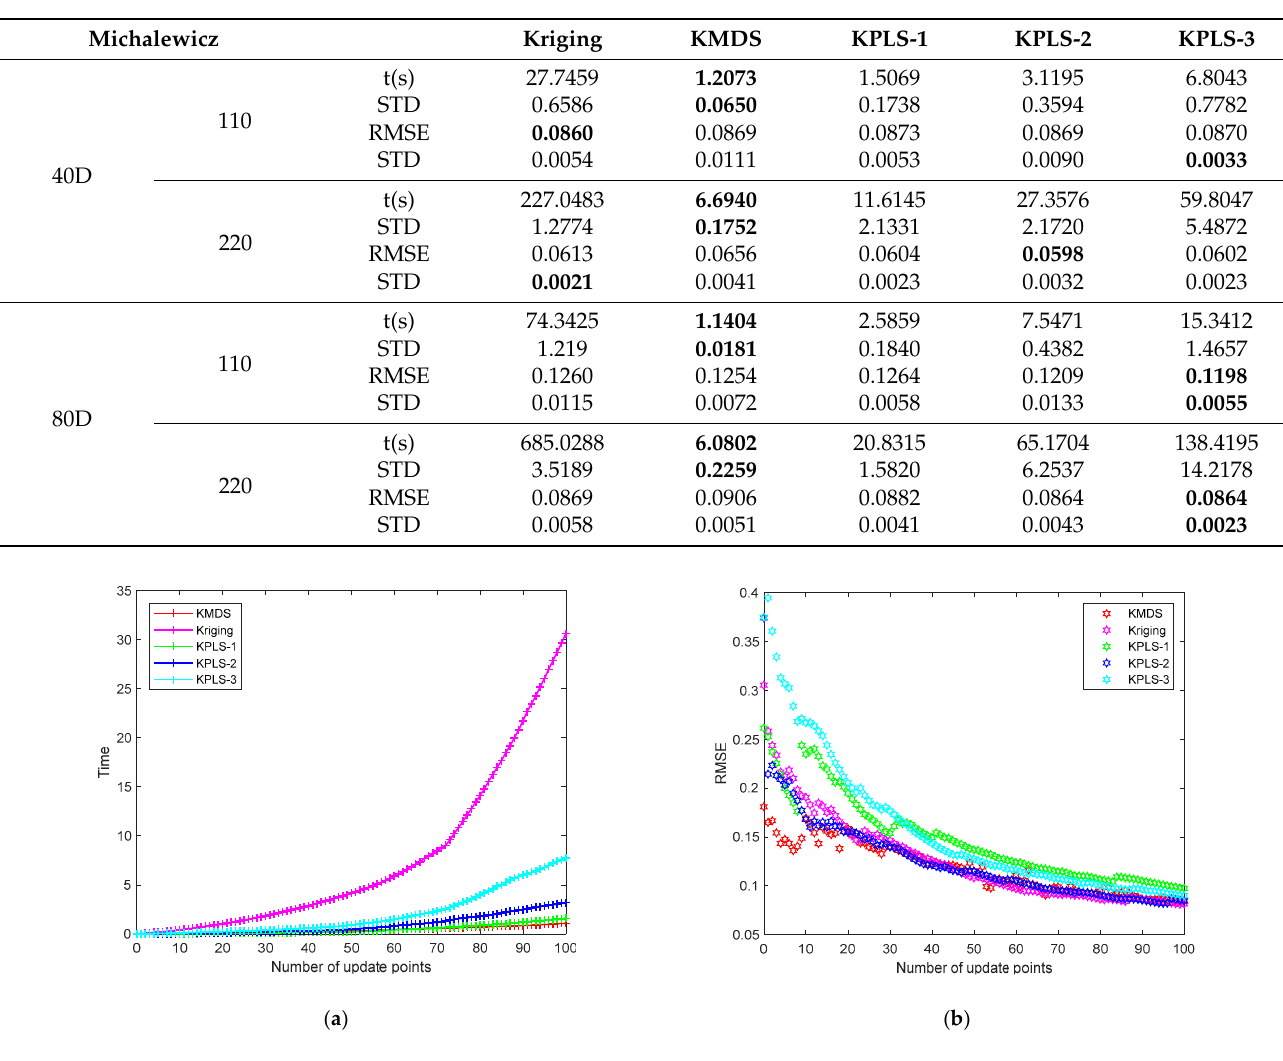
Table 5. Time and RMSE for Michalewicz function.